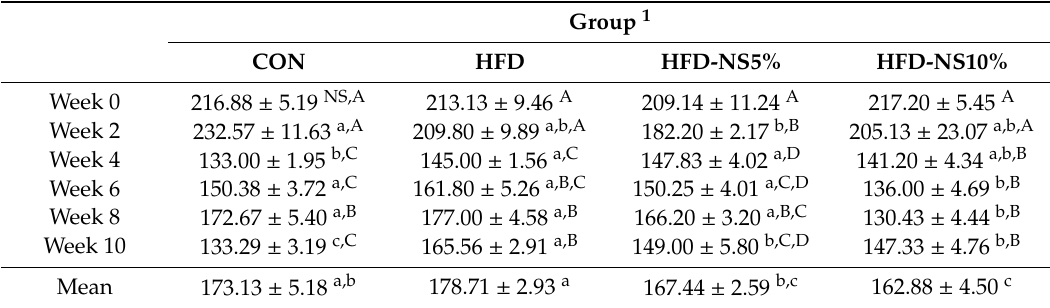
Table 5. E ff ect of Nelumbinis Semen powder on random blood glucose levels (mg / dL) at weeks 0, 2, 4, 6, 8, and 10 ( n = 8 / 161.80 ± 5.26 a,B,C